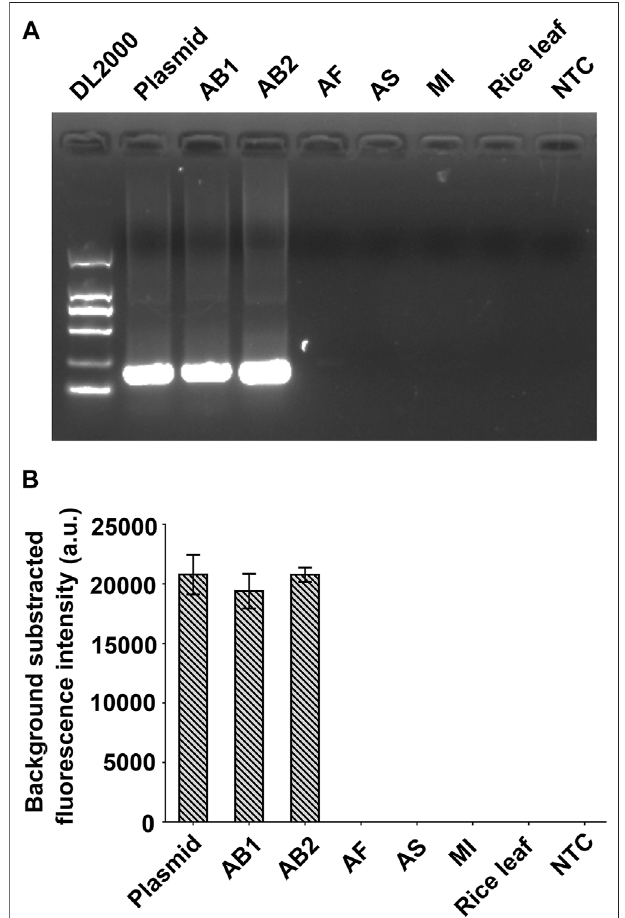
FIGURE 4 | Evaluation of the speci fi city of the RPA-Cas12a-Ab assay. (A) RPA ampli fi cation of fi ve nematodes. (B) Results of the RPA-Cas12a-Ab fl uorescence assay. The data are presented as mean ± SD ( n = 3). Plasmid pUC57-18S is used as the positive control; AB1, Aphelenchoides besseyi-1 ; AB2, Aphelenchoides besseyi-2 ; AS, Aphelenchoides subtenuis ; AF, Aphelenchoides fragariae . MI, Meloidogyne incognita ; NTC, no template